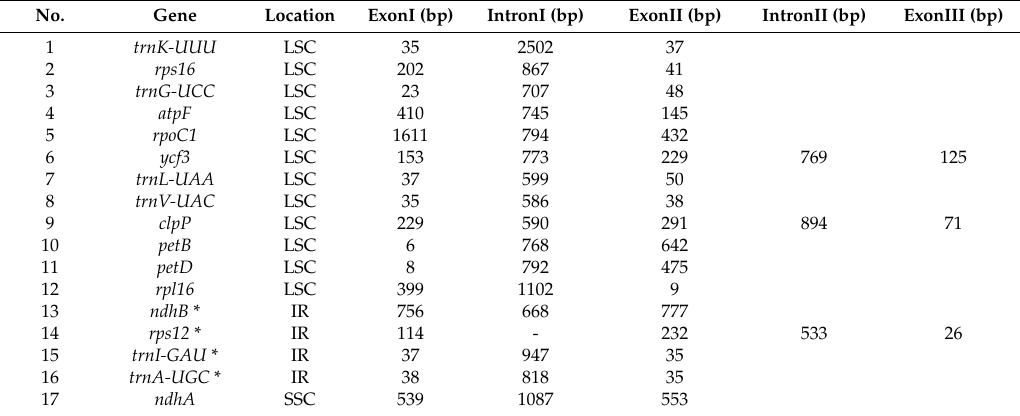
Table 3. The intron-containing genes in the T. paniculatum cp genome and the lengths of the exons and